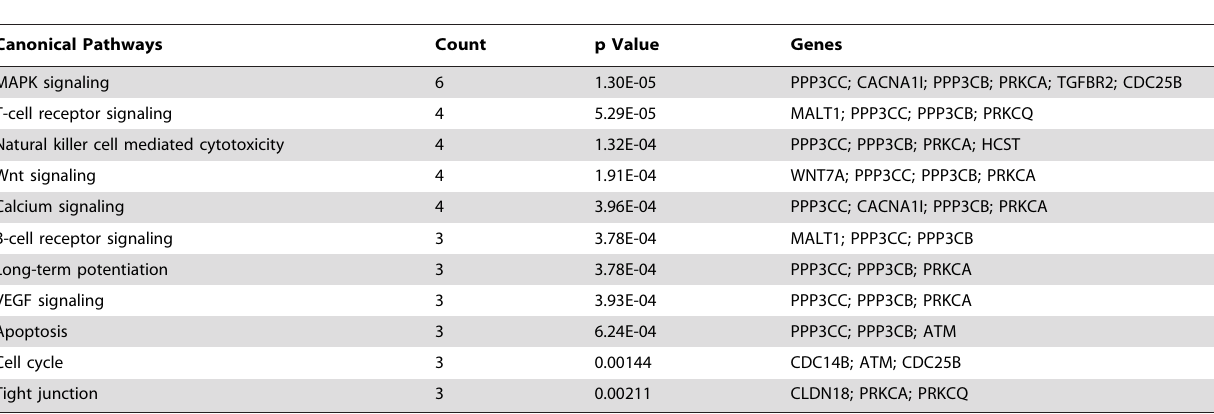
Figure 4. Predicted interaction networks of genes regulated during HIV-1 infection. Differentially regulated genes are represented in the links predicted using STRING (http://string.embl.de/). Predicted interactions represent both direct and indirect associations that are derived from four different sources: genomic context, high throughput experiments, conserved co-expression, and previous findings from the literature. The nature of the supporting evidence is indicated by the color lines: green represents neighborhood; red, gene fusion; blue, co-occurrence; black, co-expression; purple, previous experiments; turquoise, database; yellow, text mining; and aqua, homology. doi:10.1371/journal.pone.0022730.g004 Table 3. Genes upregulated in the HIV-1 infected culture compared to uninfected control cells, determined by transcriptome